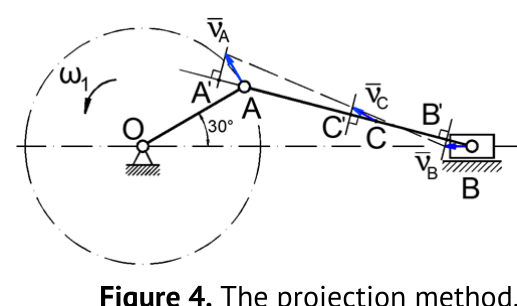
Figure 4. The projection